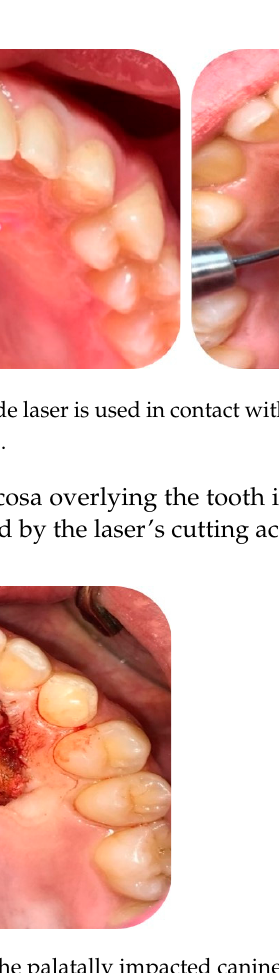
Figure 2. The tip of the CO 2 laser is used near to the tissue surface ( left ); Operculum performed with CO 2 laser ( right ).